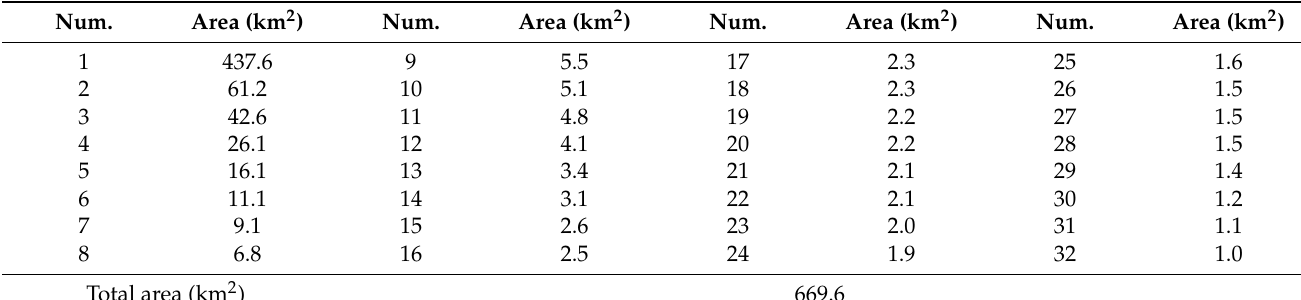
Table 2. The area of the deformation